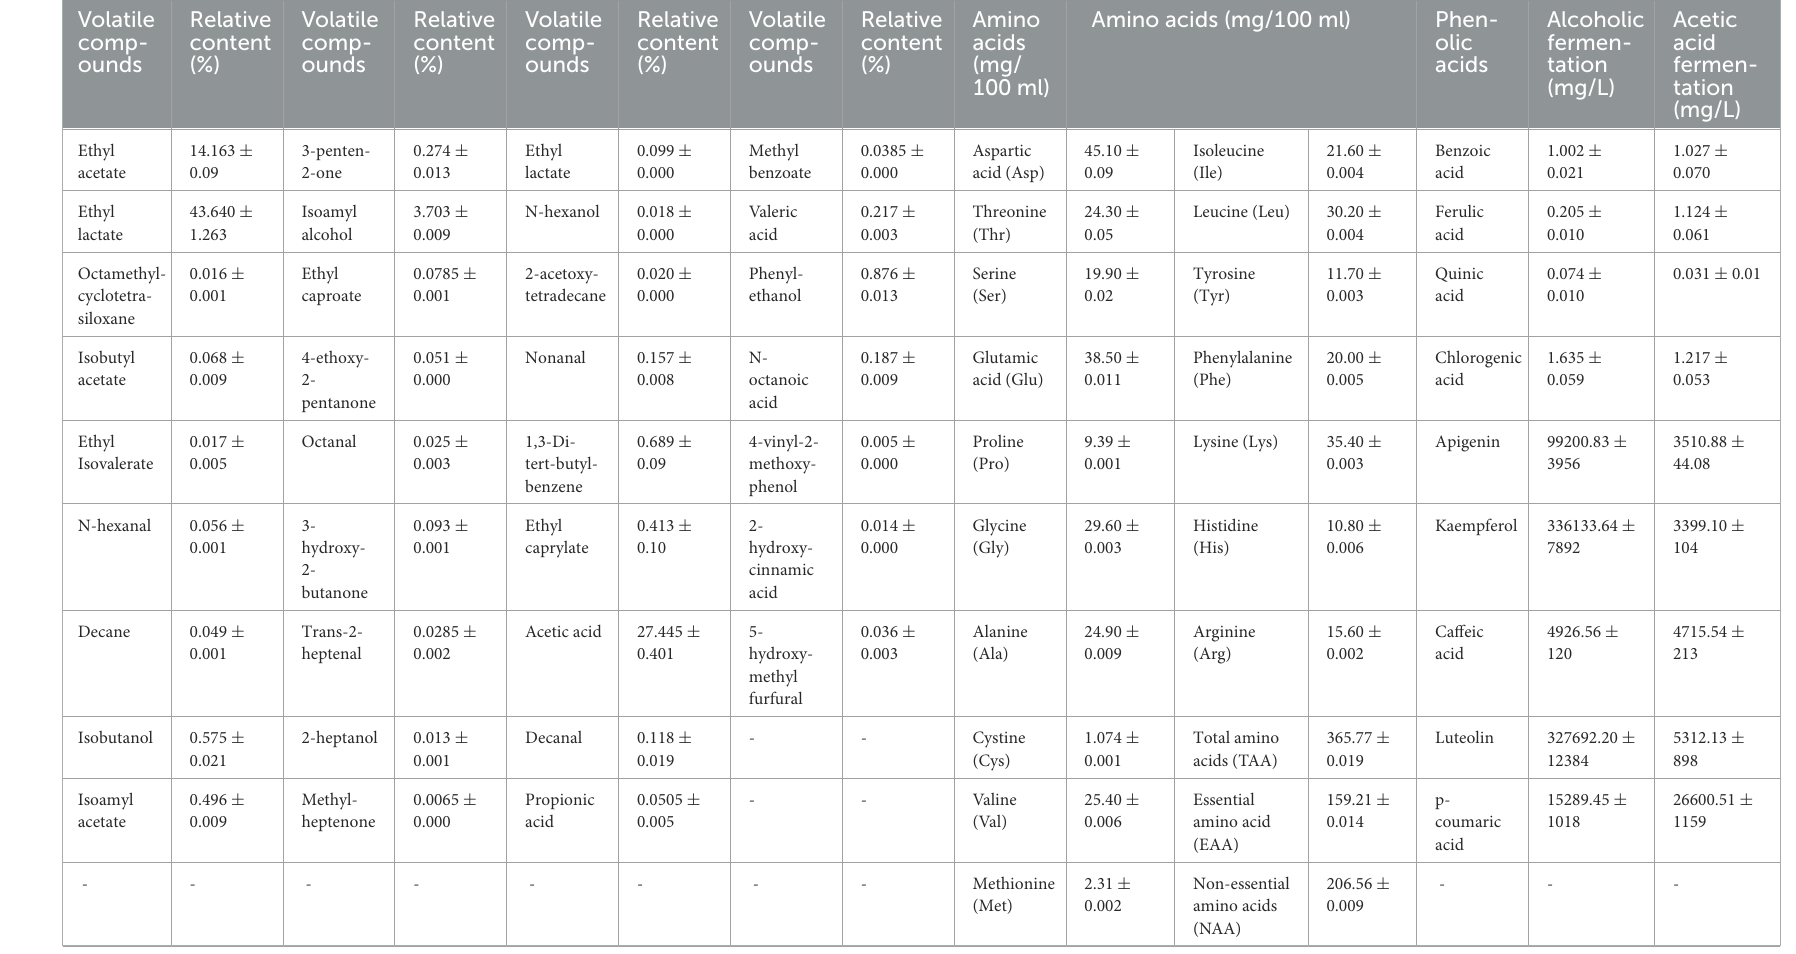
TABLE 1 Summarizing aroma compounds, organic and free amino acids in sugarcane vinegar (30,